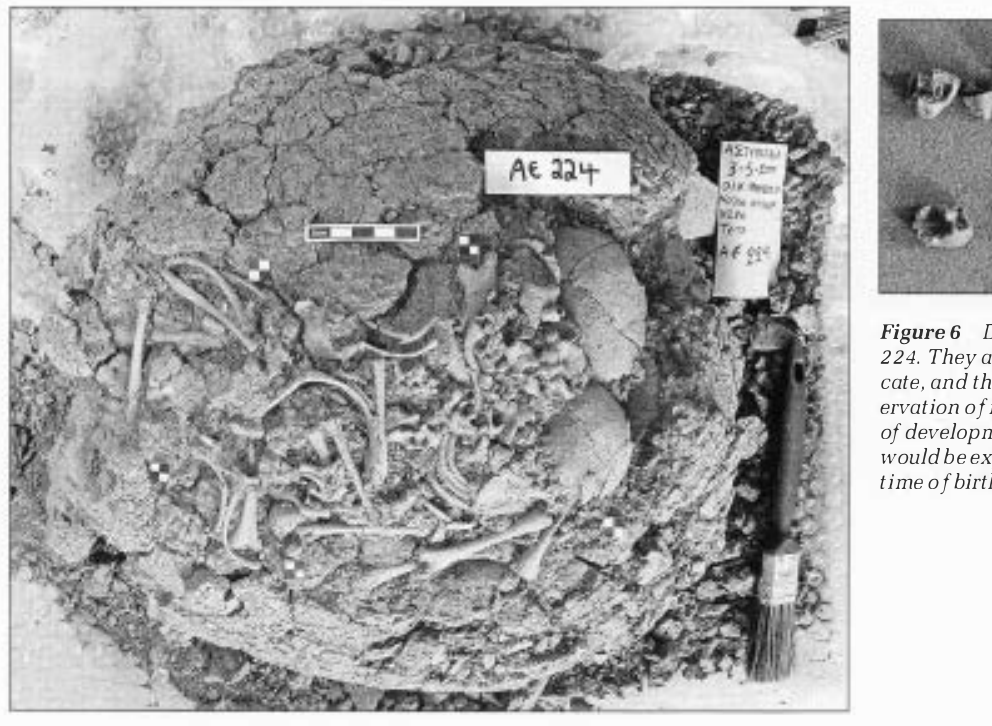
Figure 5 The exposed skeleton of the baby buried in amphora AE 224. The head is at the right, towards where the neck of the pot had been. There has been some movement of the other bones as sediment collapsed into the pot, but most of them have survived